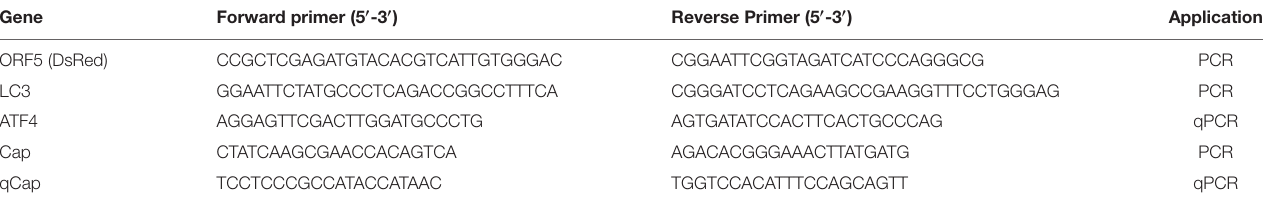
TABLE 1 | Sequences of primer pairs used for this study. Gene Forward primer (5 (cid:48) -3 (cid:48) ) Reverse Primer (5 (cid:48) -3 (cid:48) )